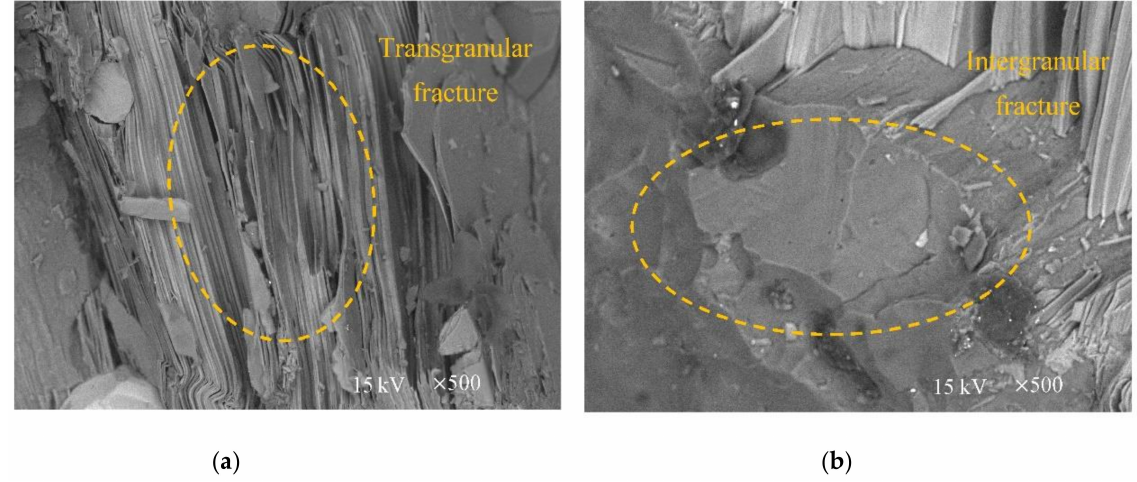
Figure 8. Scanning morphology of the fracture. ( a ) Foliated structure; ( b ) Block structure.